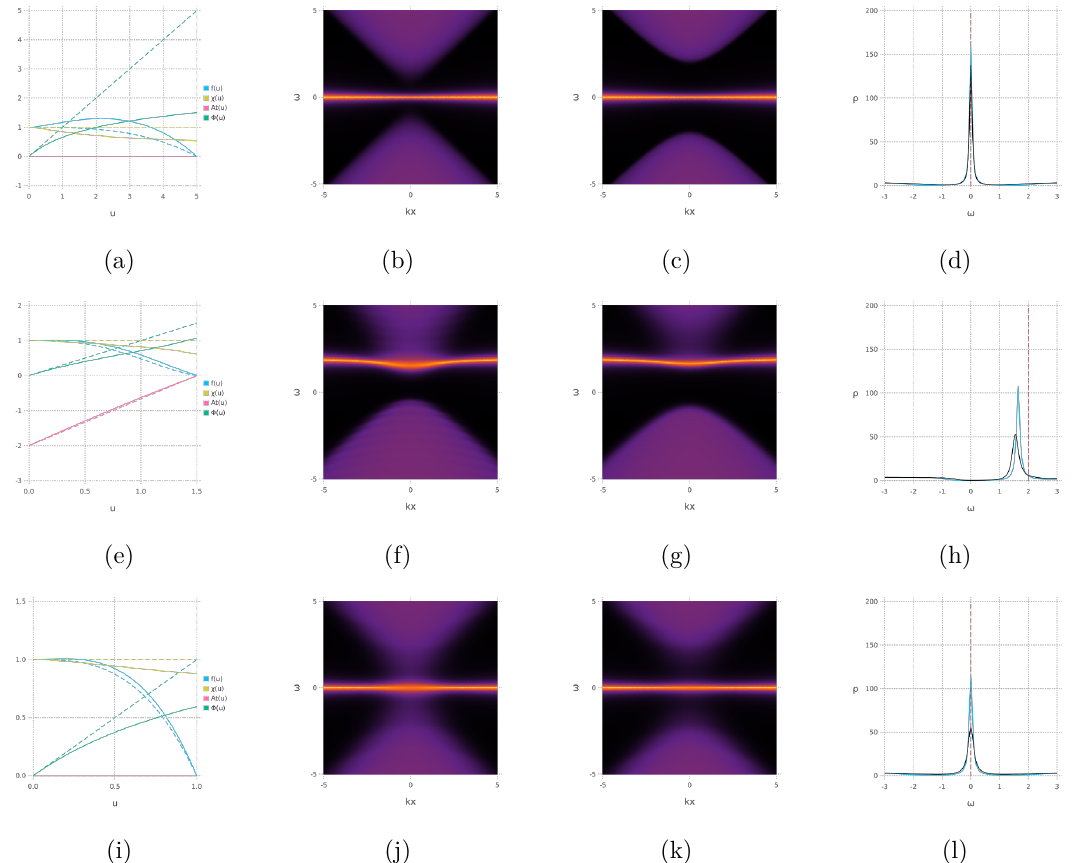
Figure 8 . Comparison of calculations with and without back reaction. (a), (e), (i) Background fields with (solid line) and without (dashed line) back reaction. (b), (f), (j) Fermion spectra with back reaction. (c), (g), (k) Fermion spectra without back reaction. (d), (h), (l) Spectral function ρ on k x = k y = 0 with (black line) and without (blue line) back reaction, and position of undeformed flat band (red dashed line). We set parameters as m = 0 , q = 1 , λ = 2 (all); µ = 0 , u h = 5 ((a), (b), (c), (d)); µ = − 2 , u h = 1 . 5 (e, f, g, h); µ = 0 , u h = 1 ((i), (j), (k),